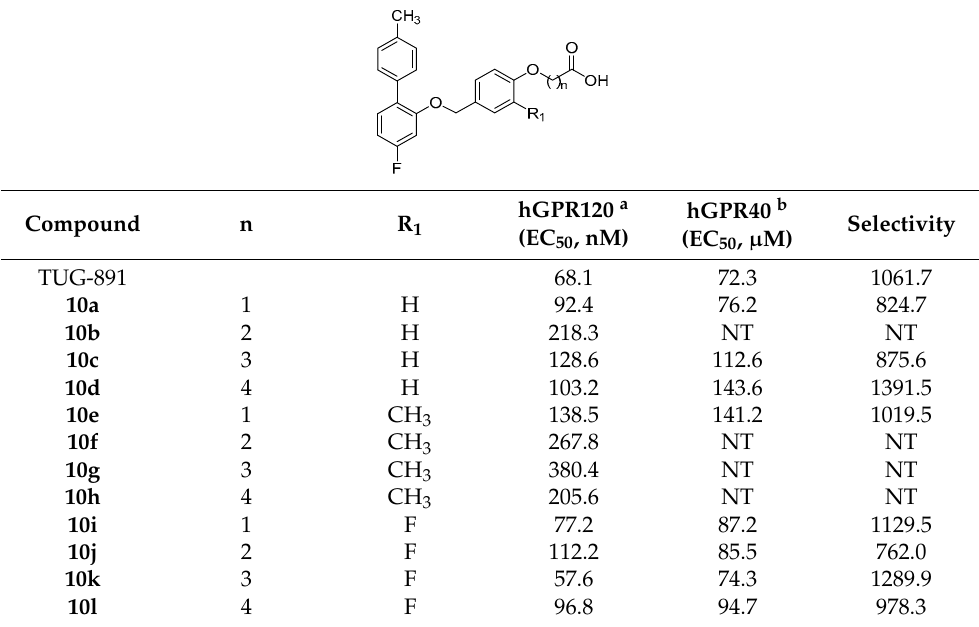
Table 1. In vitro activities and selectivity of target compounds 10a – 10l .